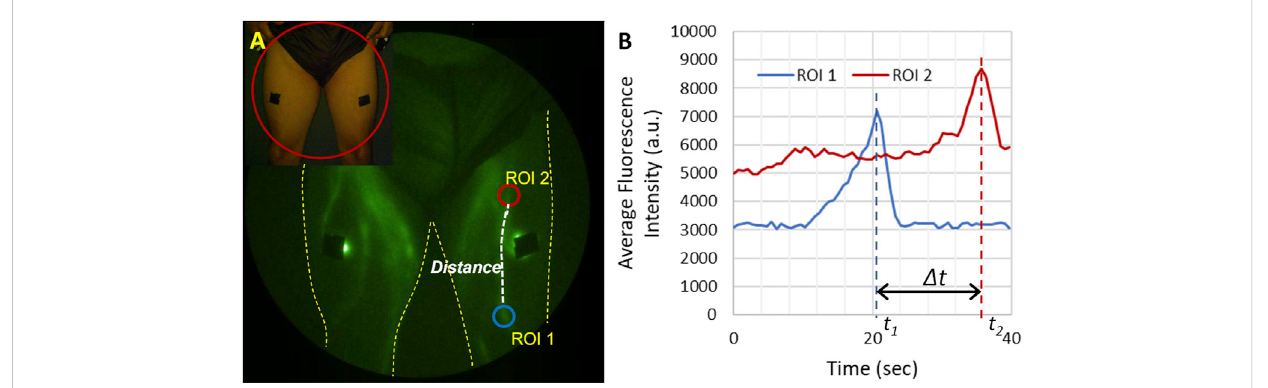
FIGURE 3 Illustration of how lymphatic propulsion is quanti fi ed. (A) Two regions of interest (ROIs) are selected along the lymphatic vessel and the distance along the vessel between ROIs is measured. (B) The average fl uorescent intensity of each ROI is then plotted as a function of time. Each bolus of lymph moving through the lymphatic vessel appears as a peak in the fl uorescent intensity. The velocity can be calculated as the distance between the two ROIs and the time it takes for the bolus to travel between the two ROIs ( Δ t ). The propulsion rate is the total number of propulsion event observed in one ROI divided by the total imaging